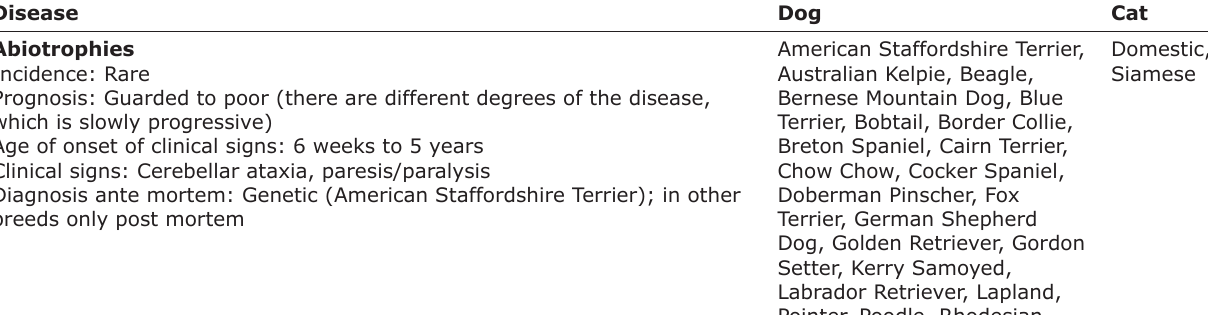
Table-1: Breeds affected by inherited neurologic diseases [9,10,34-38]. Disease